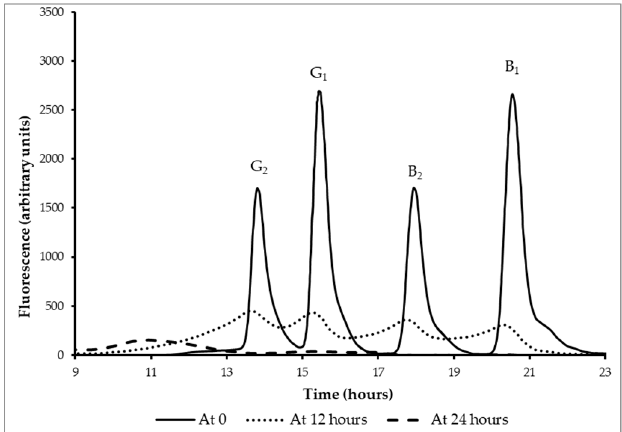
Figure 3. Reduction of aflatoxins B 1 , B 2 , G 1 , and G 2 during controlled fermentation of the traditional maize-based kwete. HPLC chromatograms (fluorescence at 450 nm (arbitrary units) as a function of time (hours)) of immunoaffinity-purified water-soluble fractions of kwete after 0, 12, and 24 hours of fermentation.